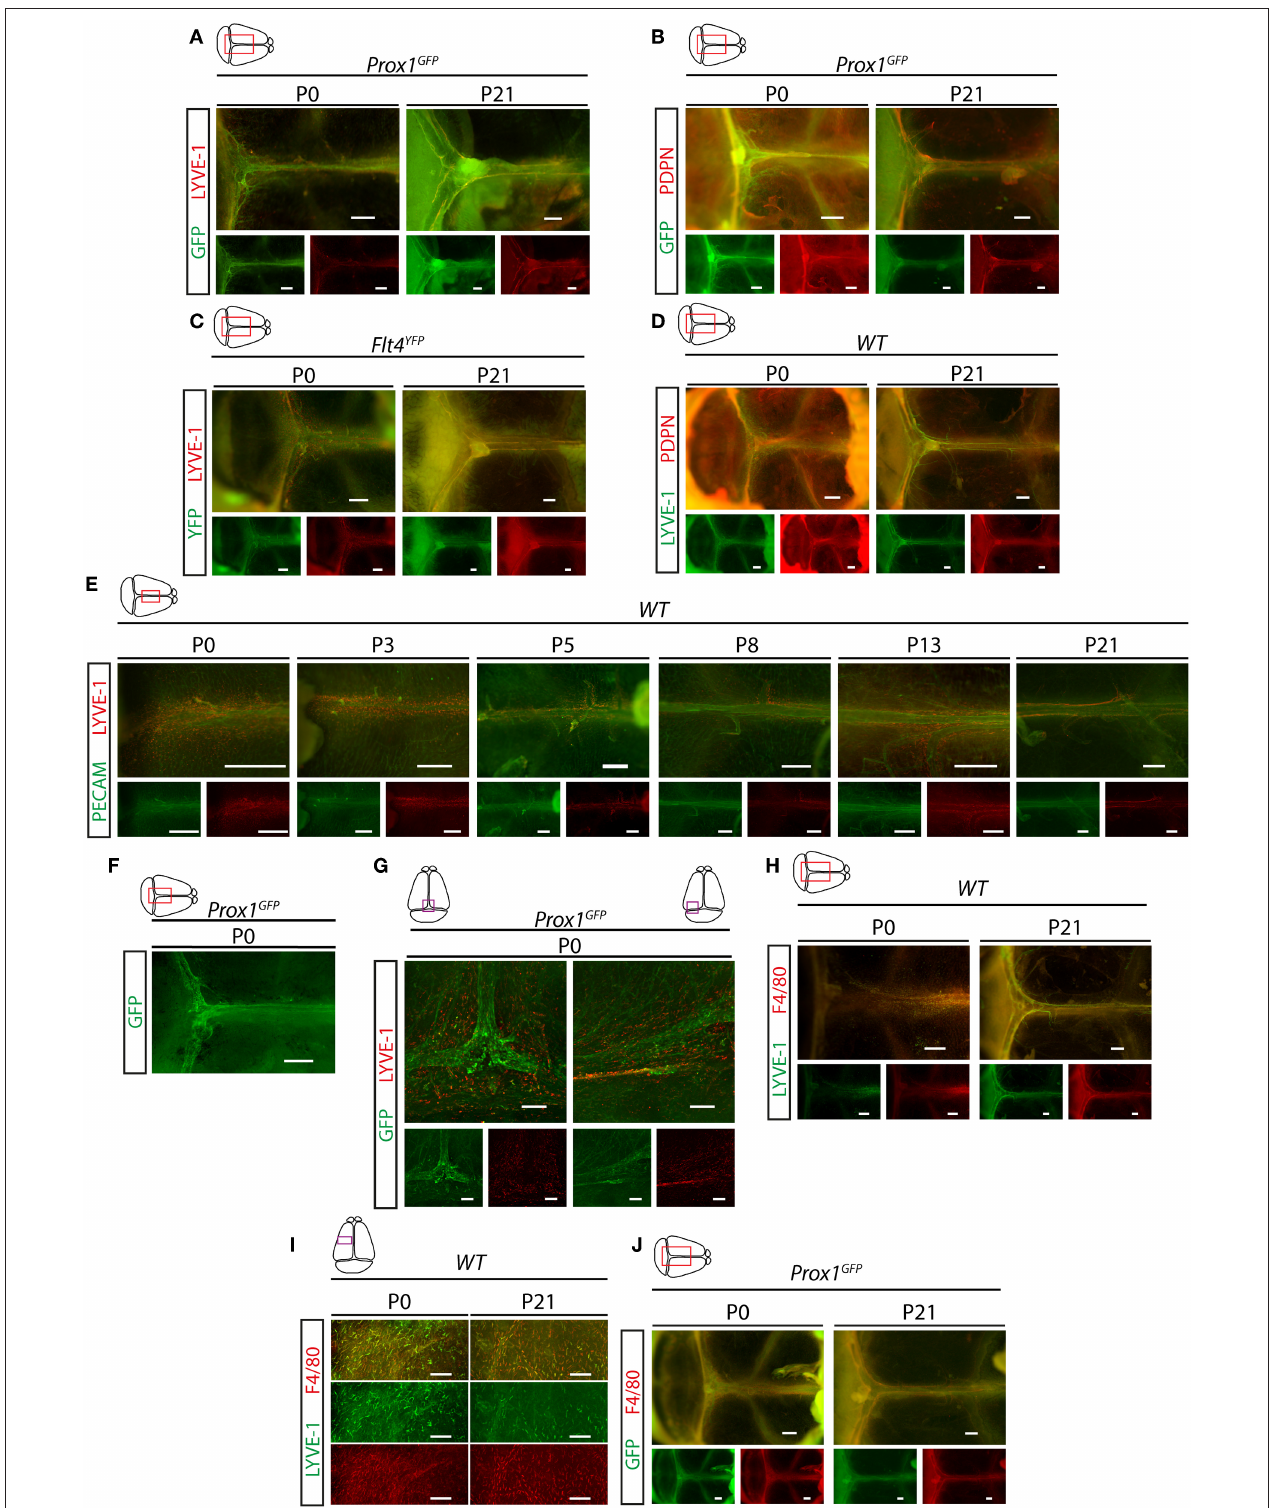
FIGURE 3 | Characterization of the developmental program of meningeal lymphatics. (A) Expression of GFP and LYVE-1 adjacent to the venous sinuses of whole-mount immunostained meninges of Prox1 GFP lymphatic reporter mice at P0 and P21 (P0 n = 9; P21 n = 6). Bars, 500 µ m. (B) Expression of GFP and PDPN